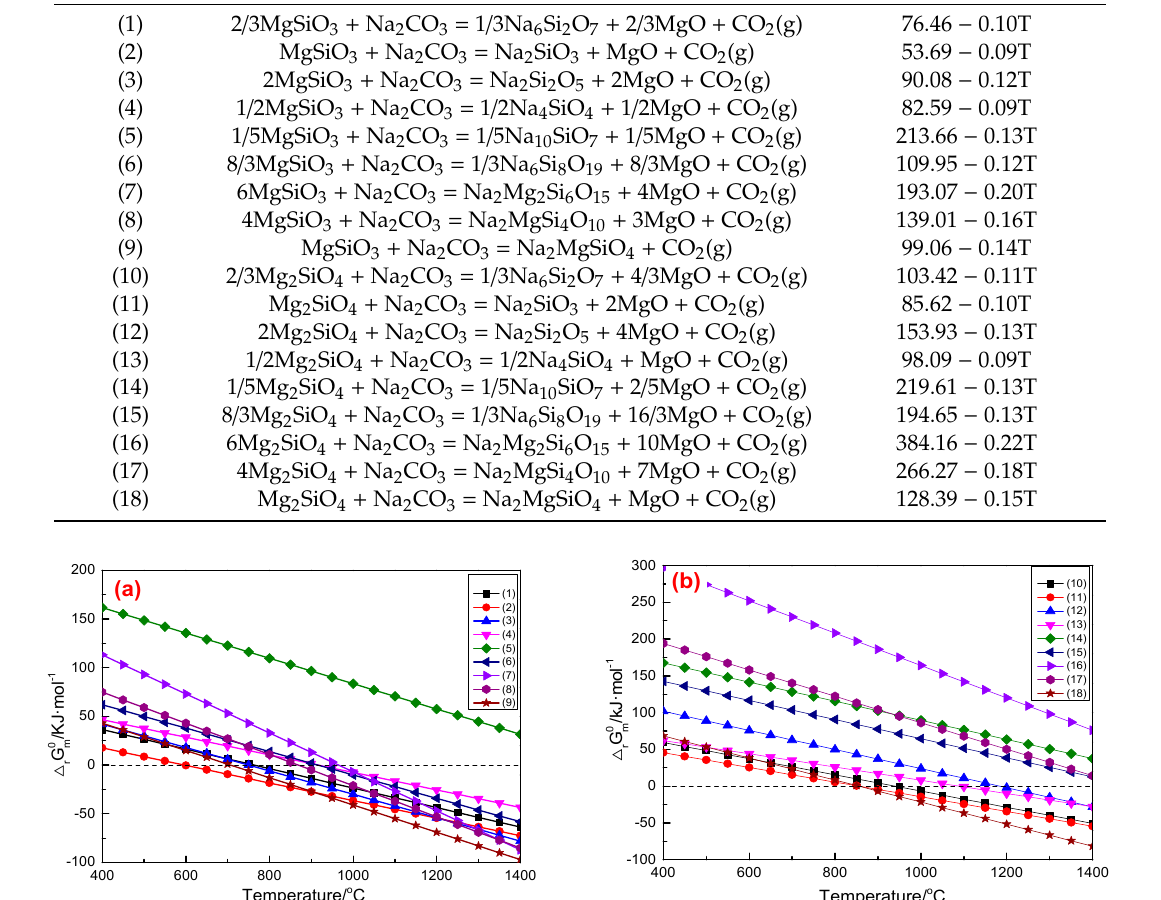
Table 2. ∆ rG m Θ − T equations of Na 2 CO 3 -MgO-SiO 2 system during roasting (400 ◦ C < T < 1400 ◦ C).